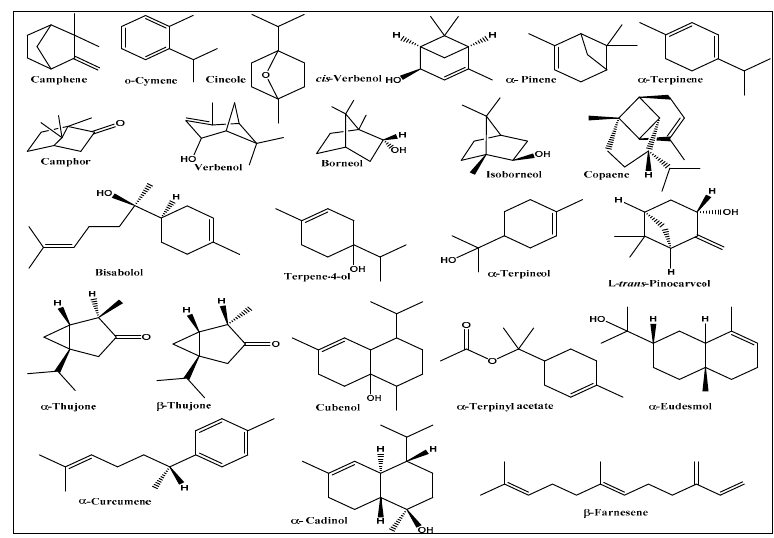
of C. morifolium flower heads.